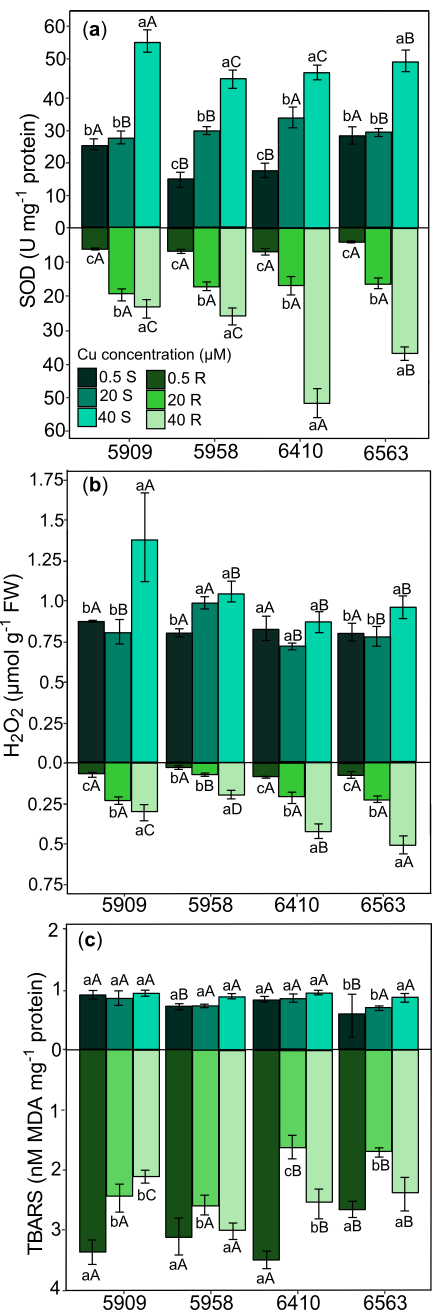
Figure 3 - Enzymatic activity of superoxide dismutase ( a ), hydrogen peroxide concentration ( b ) and malondialdehyde concentration ( c ) of four soybean cultivars (5909, 5958, 6410 and 6563) grown in nutrient solution at three different Cu concentrations (0.5, 20 and 40 µM). Capital letters indicate comparison between cultivars in the same Cu concentration. Lowercase letters indicate comparison between Cu concentrations in the same cultivar (p <0.05). Vertical bars represent ± standard